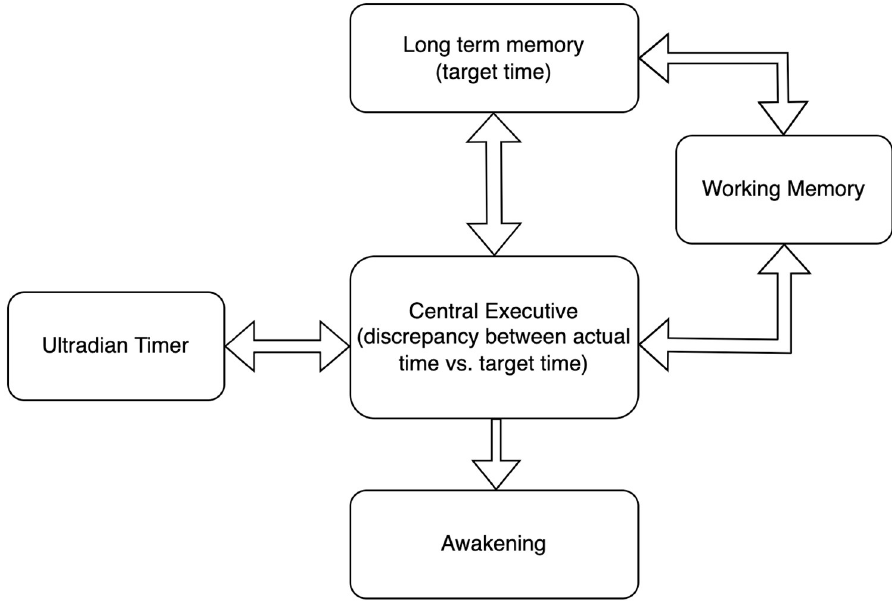
Fig 5. Proposed schematic model of the cognitive operations potentially involved in